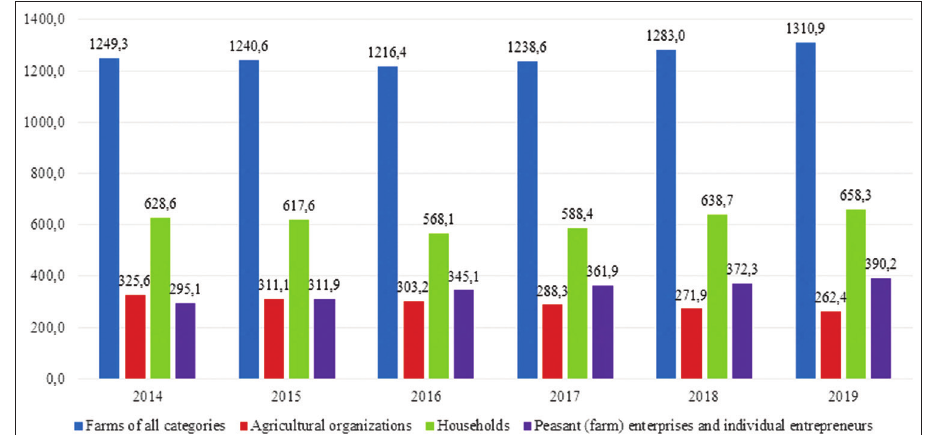
Figure-1: Number of horses on farms of all categories of the Republic of Bashkortostan for the years 2014-2019 (thousand heads).